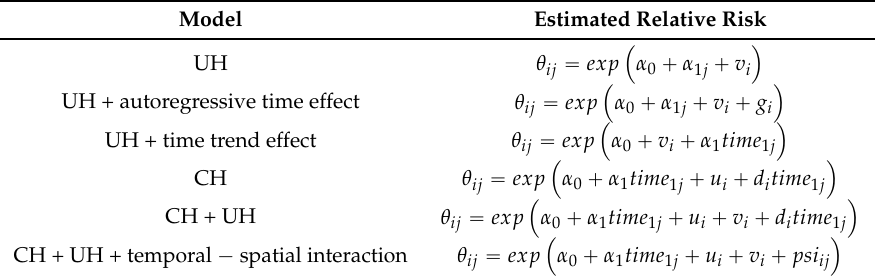
Table 1. Statistical models constructed based on Bayesian methodology. Model Estimated Relative